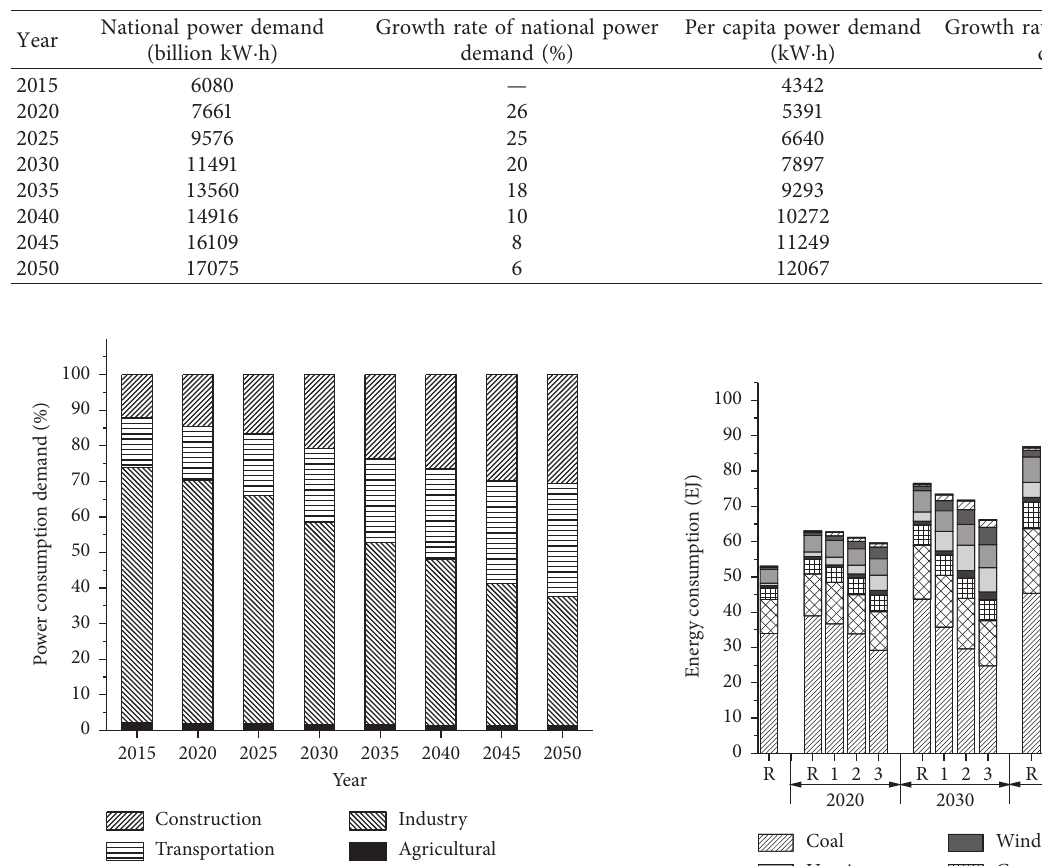
Table 3: Characteristics of power demand in China.